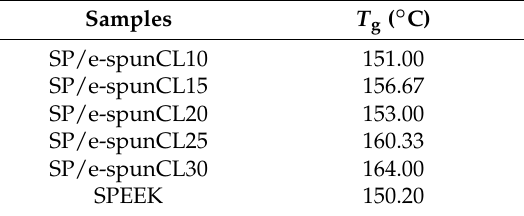
Table 4. Glass transition temperatures of SP/e-spunCL samples and SPEEK.